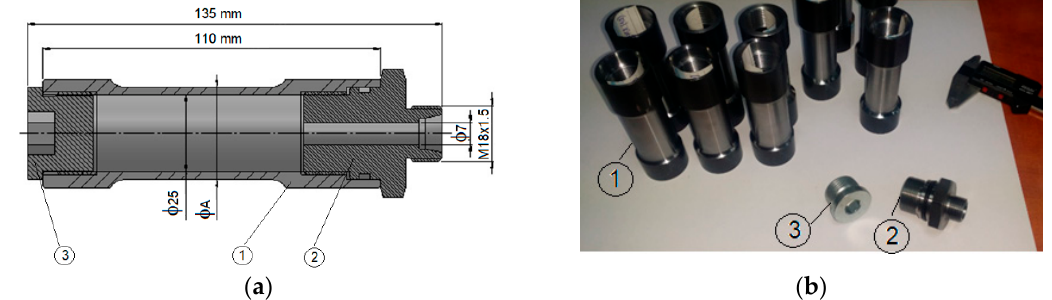
Figure 1. The shape of tested specimens: ( a ) The design of a sample section with a 2D view; ( b ) actual samples with joint bushing (1: steel honed pipe; 2: joint hex-nipple M118x1.5; 3: metallic cork with gasket).